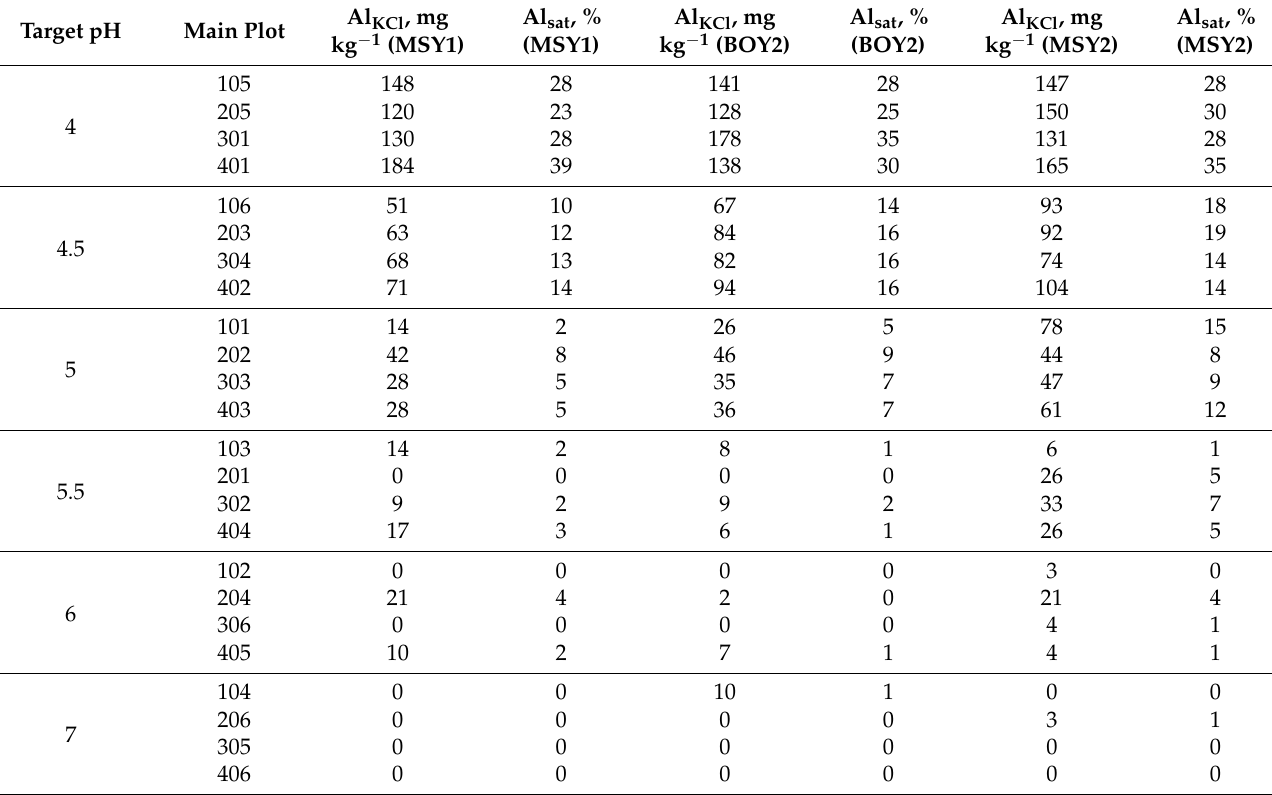
Table 2. Continuous monitoring for 2 winter wheat cropping seasons regarding exchangeable Al (Al KCl ) and Al saturation (Al sat ) for each main plot at Stillwater. Target pH